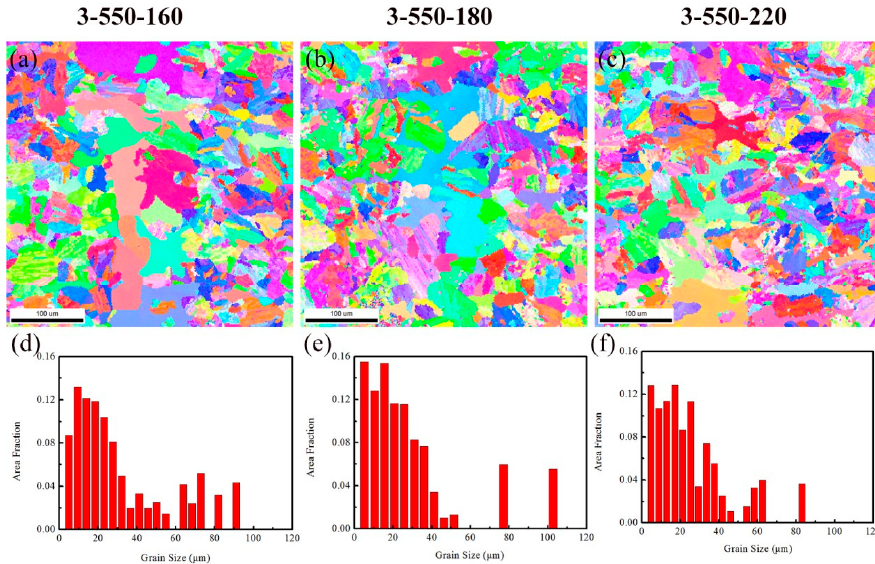
Figure 11. The EBSD results of the weld zone of the creep samples for different stresses: ( a – c ) are IPF maps; ( d – f ) are grain-size statistical diagrams.